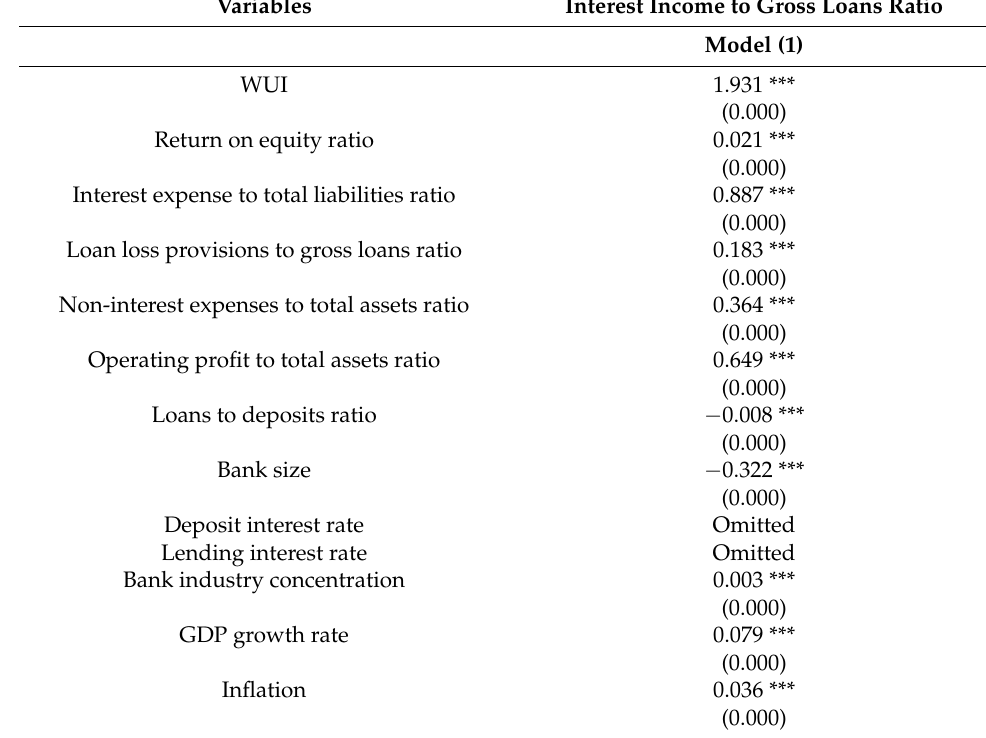
Table 7. Economic and political uncertainty and bank loan pricing: Robustness test with extended sample size. This table reports results of robustness checks regarding the impact of policy uncertainty on bank loan interest rates. Bank loan interest rate is measured with annual ‘interest income to gross loans ratio’ and is the dependent variable in all models. WUI is the world uncertainty index of Ahir et al. (2018), which represents economic uncertainty. EPU index is the economic policy uncer- tainty index of Baker et al. (2016). Others are control variables. Two control variables, Deposit interest rate and Lending interest rate, are omitted from this regression to maximize sample size. Detailed definitions of variables are given in Table 2. The results are estimated with pooled OLS estimator using heteroskedasticity robust standard errors. P -values are given in parenthesis. *** represents statistical significance at 1%